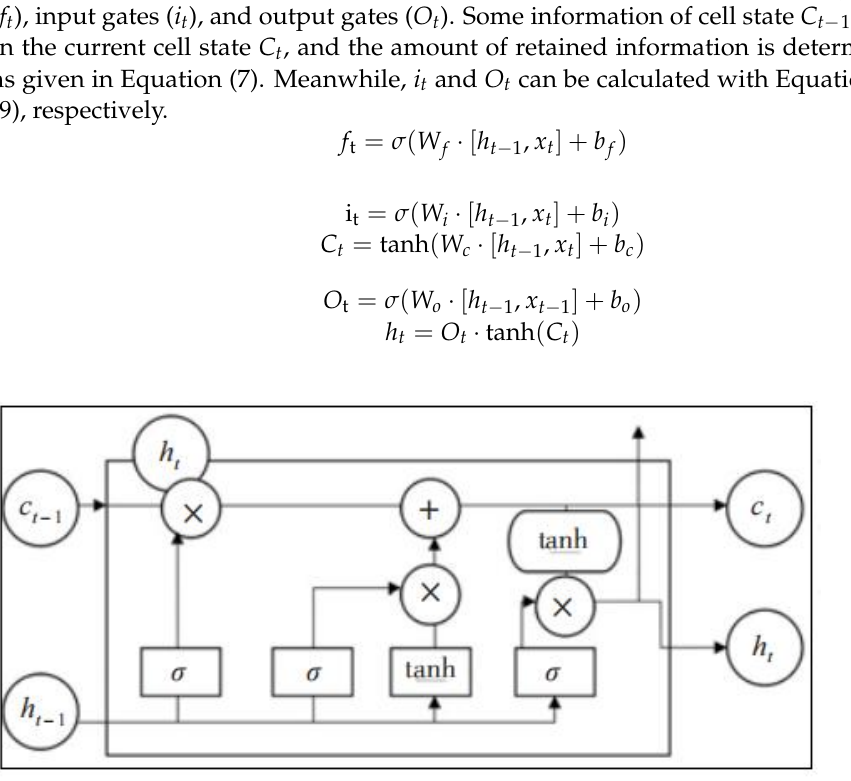
Figure 7. Network structure of the standard LSTM.